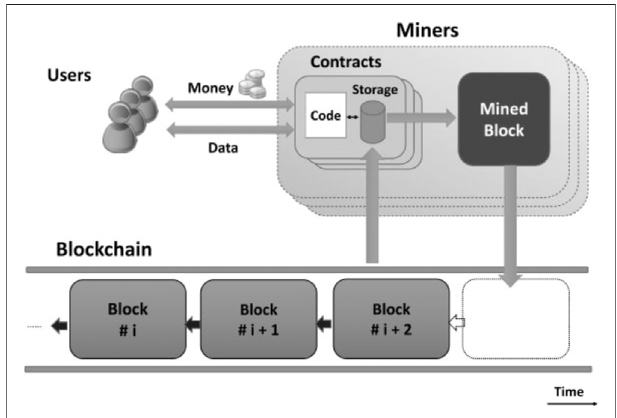
FIGURE 8 | Smart contract system? (Delmolino et al.,